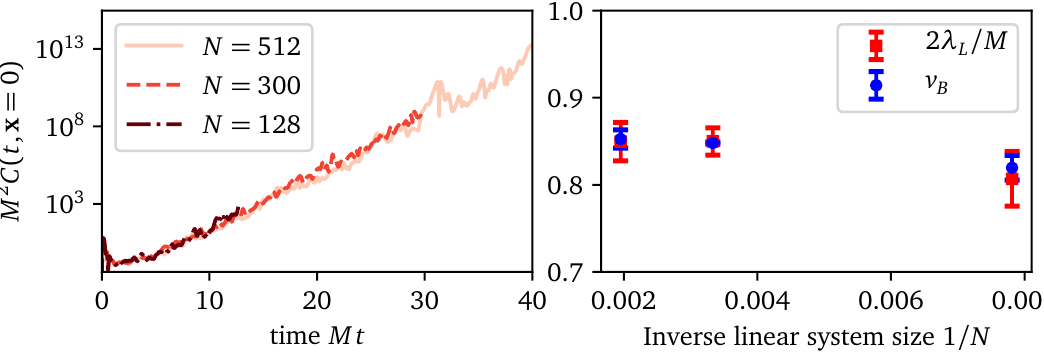
Figure 9: Convergence of the OTOC at G = 61.5 with system size. Both the con- vergence of the local OTOC (left) as well as butterfly velocity and lyapunov exponent (right) with respect to system size indicate that there are no considerable finite size effects for N = 300, the system size chosen for most plots in the main text. We stopped the simulations at times t Na to avoid boundary s ∼